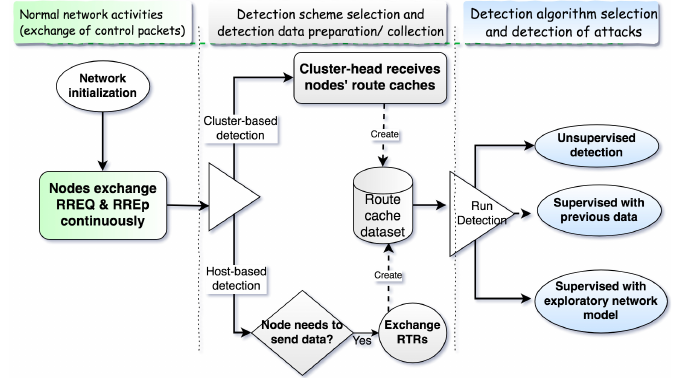
Figure 2. Detection process overview.